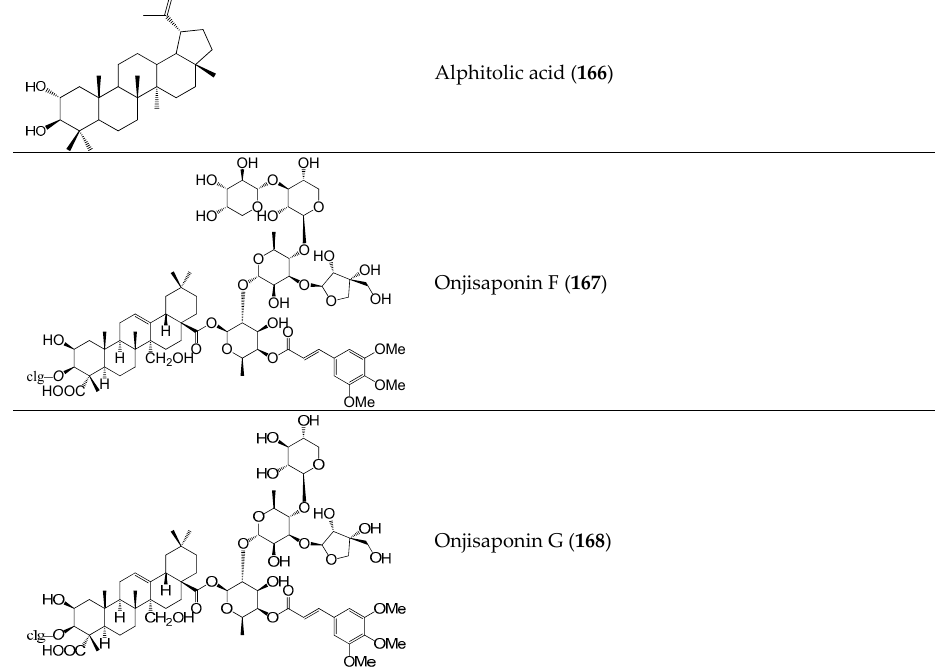
Figure 5. Figure 5.